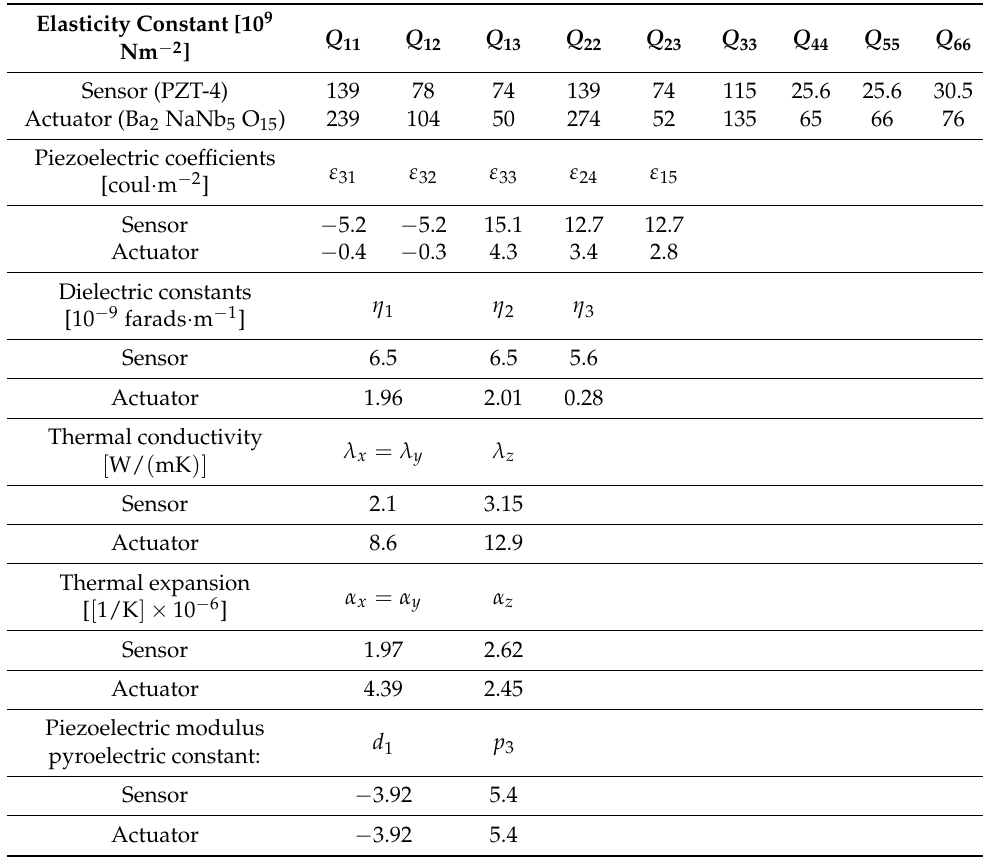
Table 1. Material properties of the piezoelectric sensor and actuator layers